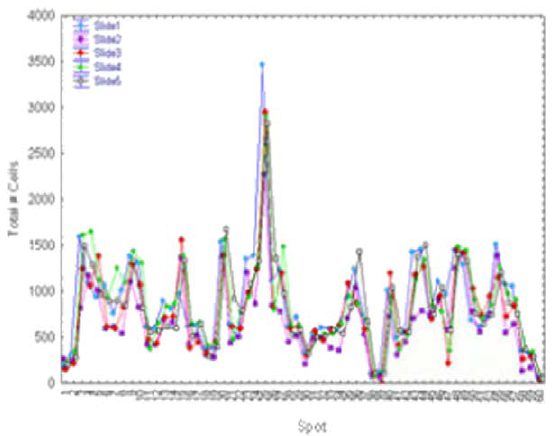
Fig. 3. Five different slides showing the total number of cells per dot per